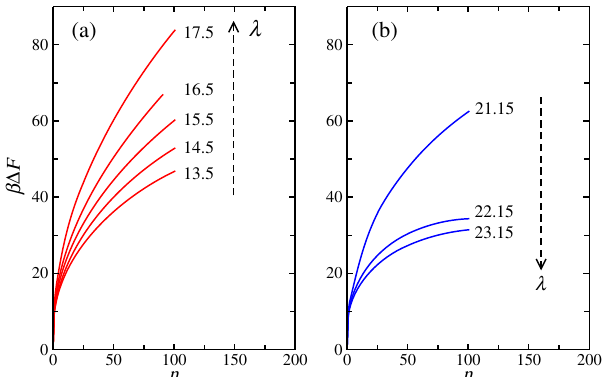
FIG. 6. Free-energy barriers computed along the homologous 0 . 8 . Panels (a) and (b) plot the barriers in the region line T=T m ¼ of stability of the bcc and dc crystals, respectively.